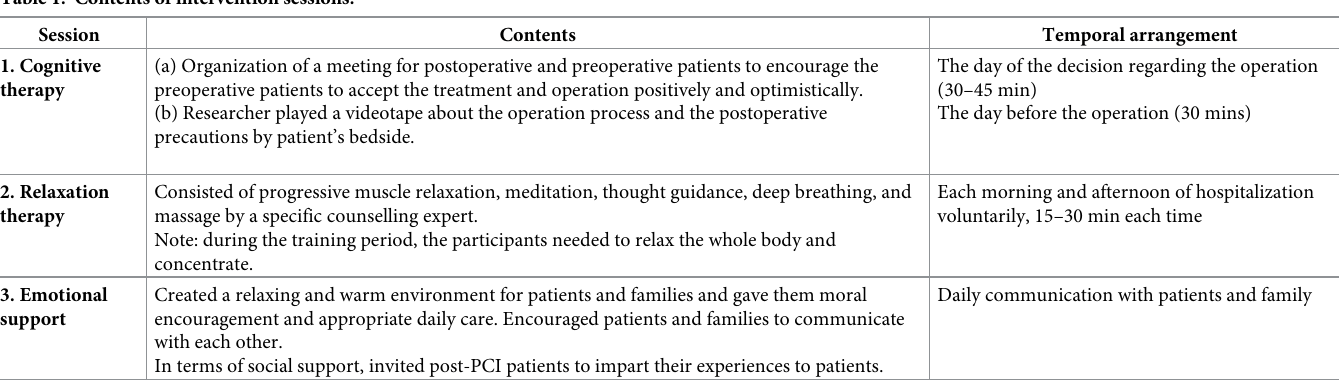
Table 1. Contents of intervention